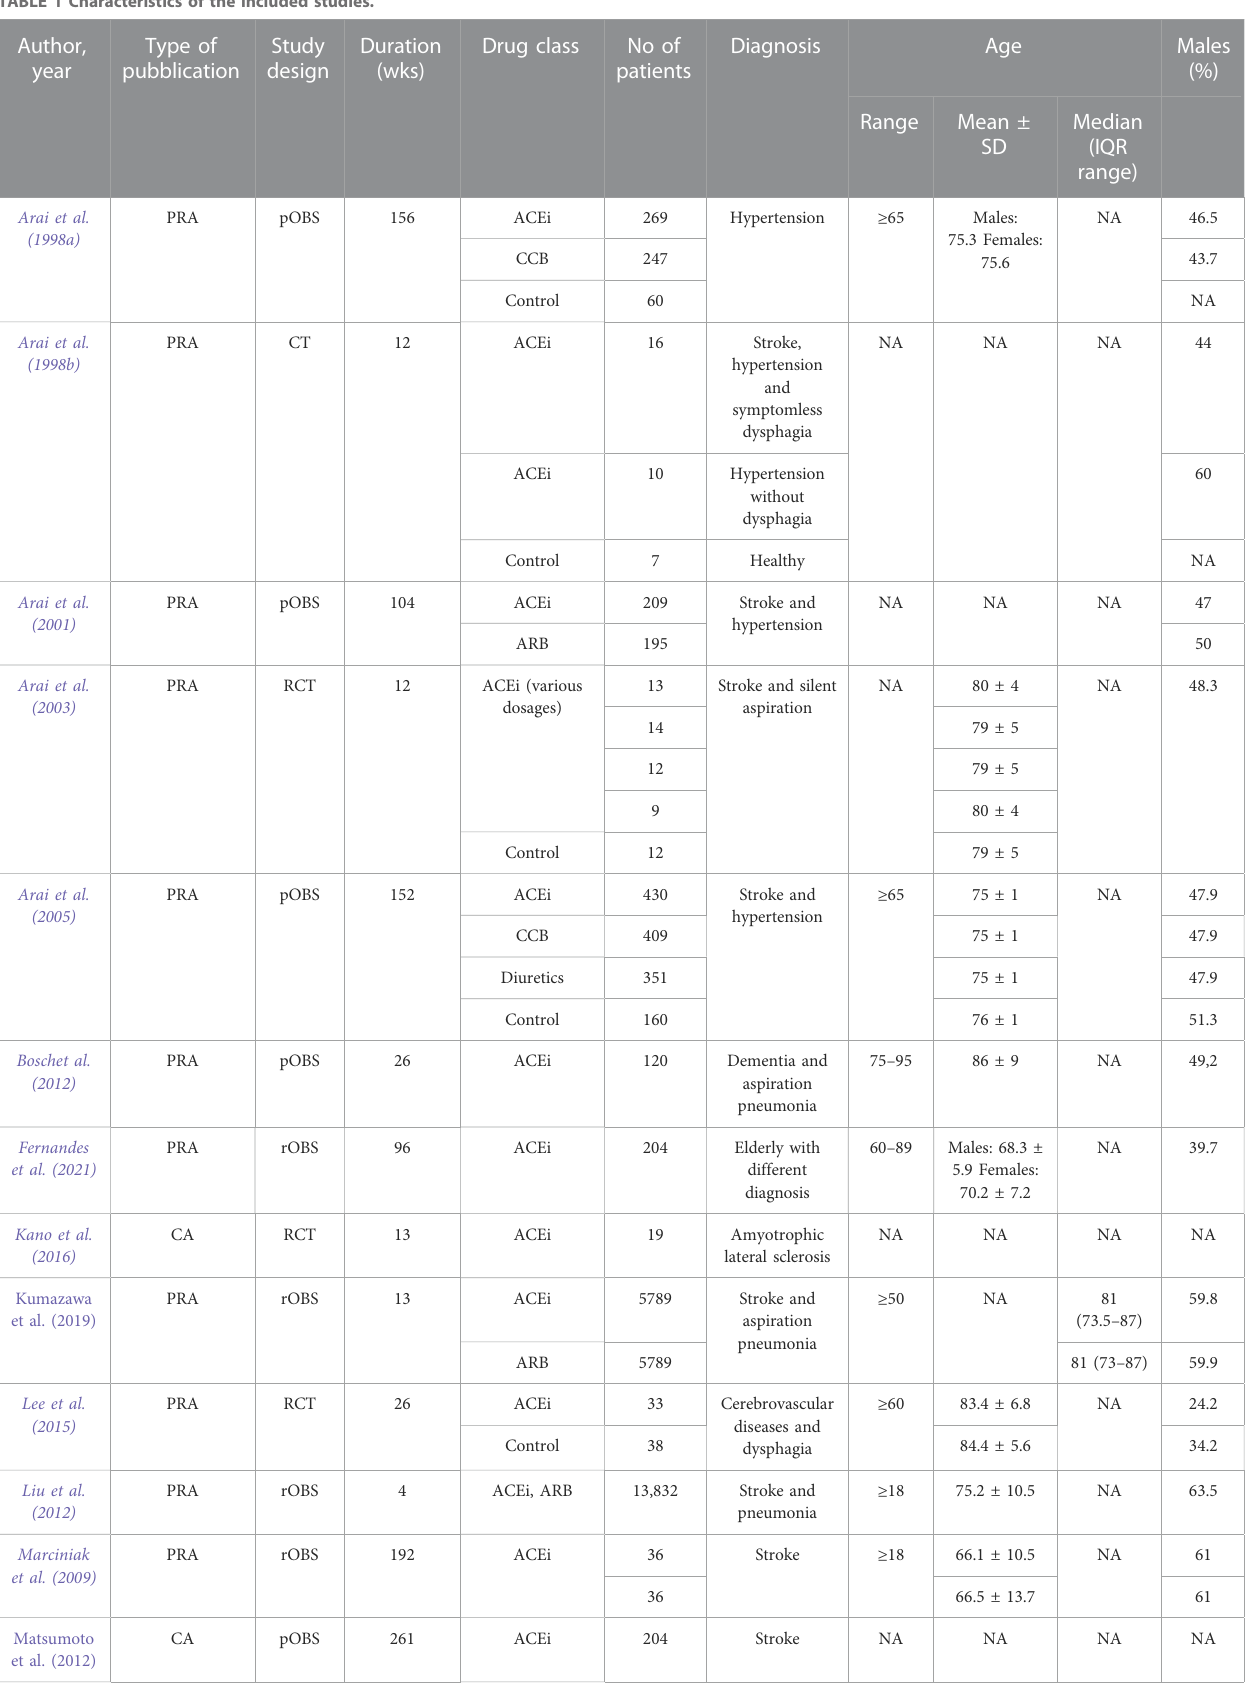
TABLE 1 Characteristics of the included